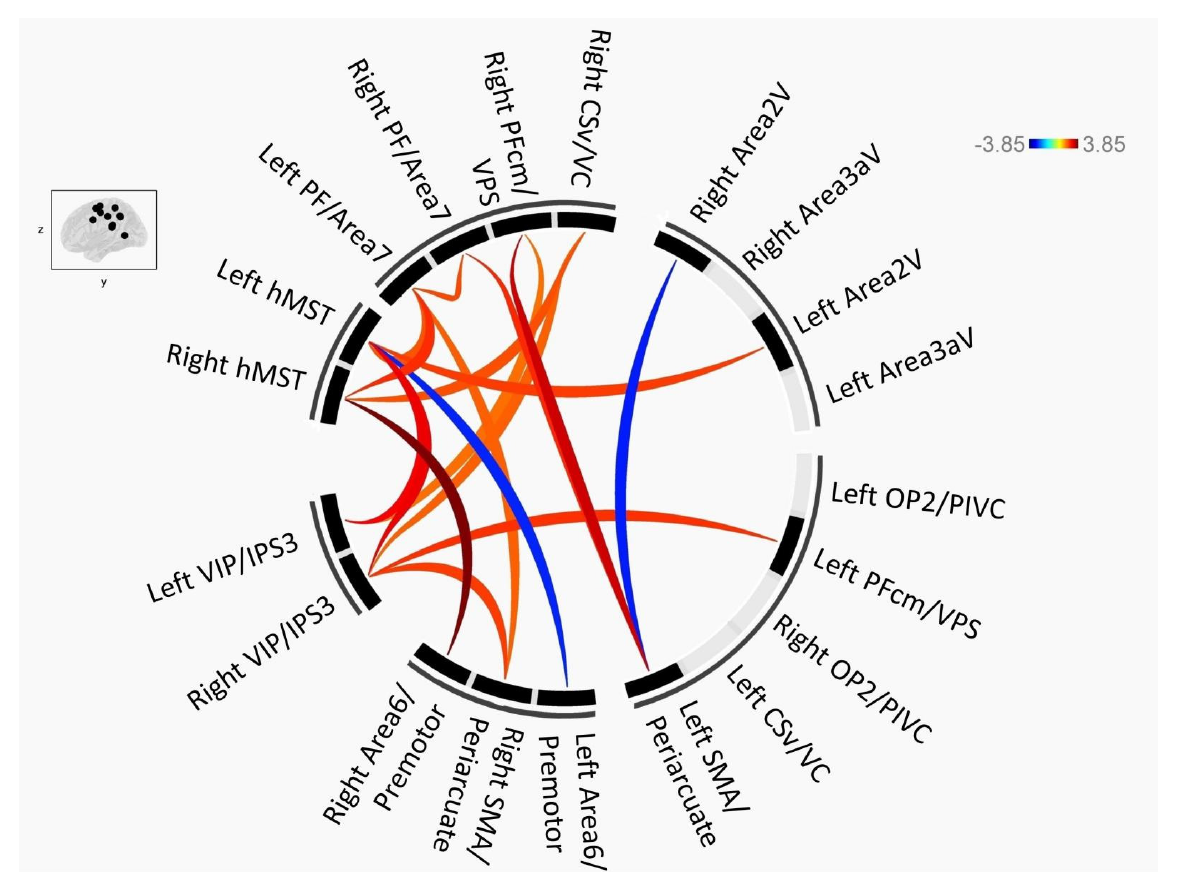
Figure 1. Connectogram depicting the differences in brain connectivity between the MCI group